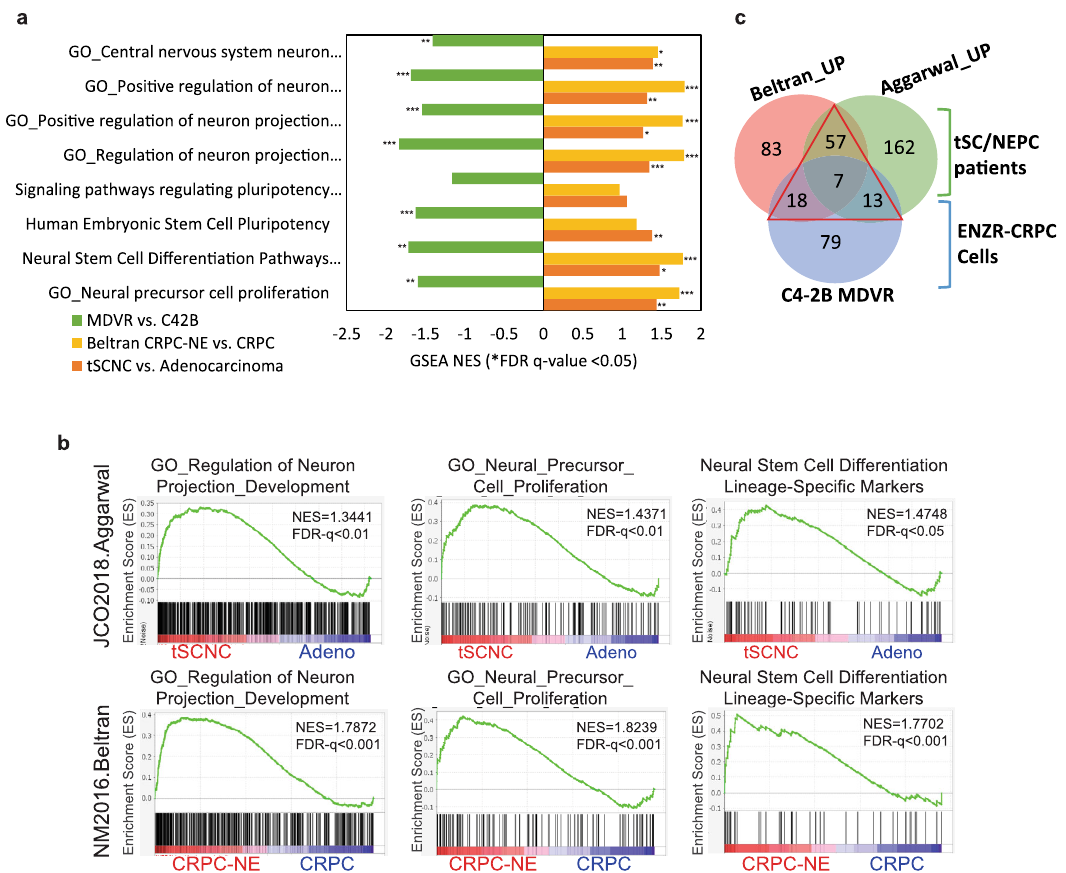
Fig. 2 Neural lineage pathways both enriched in clinical neuroendocrine prostate cancer patients and enzalutamide-resistant prostate cancer cell model. a Parallel comparison of neural lineage network in clinical NEPC patients and enzalutamide refractory prostate cancer cell model C4-2B MDVR. b GSEA enrichment plots of the neural lineage gene sets between the indicated groups showing NES scores and corresponding signi fi cance in the C4-2B MDVR vs. C4-2B parental cells (green), NEPC patients vs. CRPC patients (yellow), and t-SCNC patients vs. prostate adenocarcinoma (orange). *FDR q value <0.05, **FDR q value <0.01, ***FDR q value <0.001. c Venn diagram showing the number of upregulated genes from neural lineage pathways among Beltran, Aggarwal ’ s patient datasets (Wilcox rank-sum test p < 0.05), and C4-2B MDVR cells (|log 2-fold change|>1, FPKM value >1). NEPC neuroendocrine prostate cancer, GSEA Gene Set Enrichment Analysis, t-SCNC treatment-emergent small-cell neuroendocrine prostate